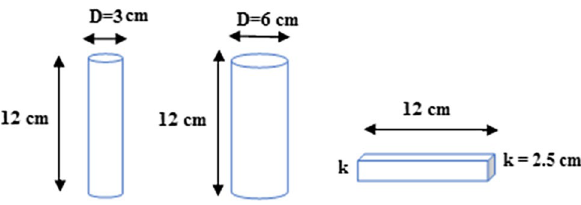
Fig. 1 Roughness element geometry